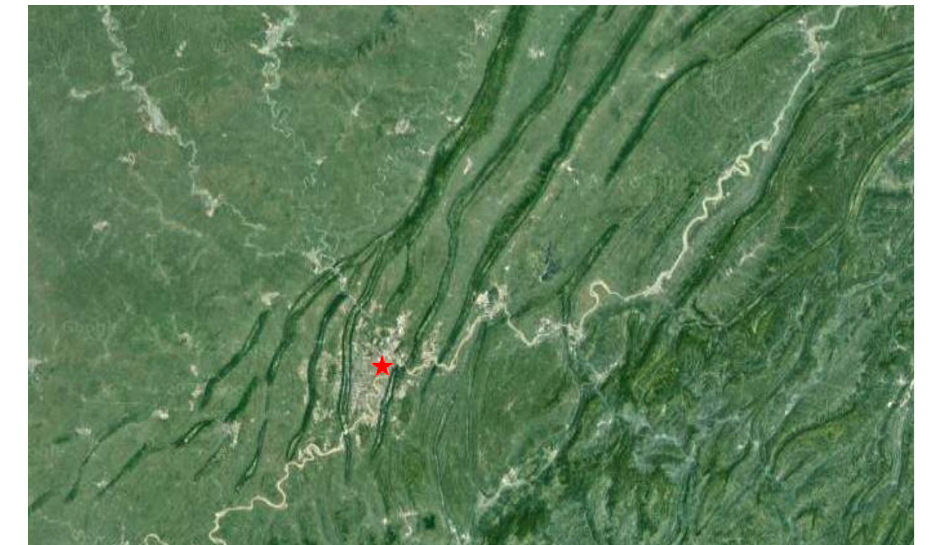
Figure 1. Chongqing city centre and its surrounding